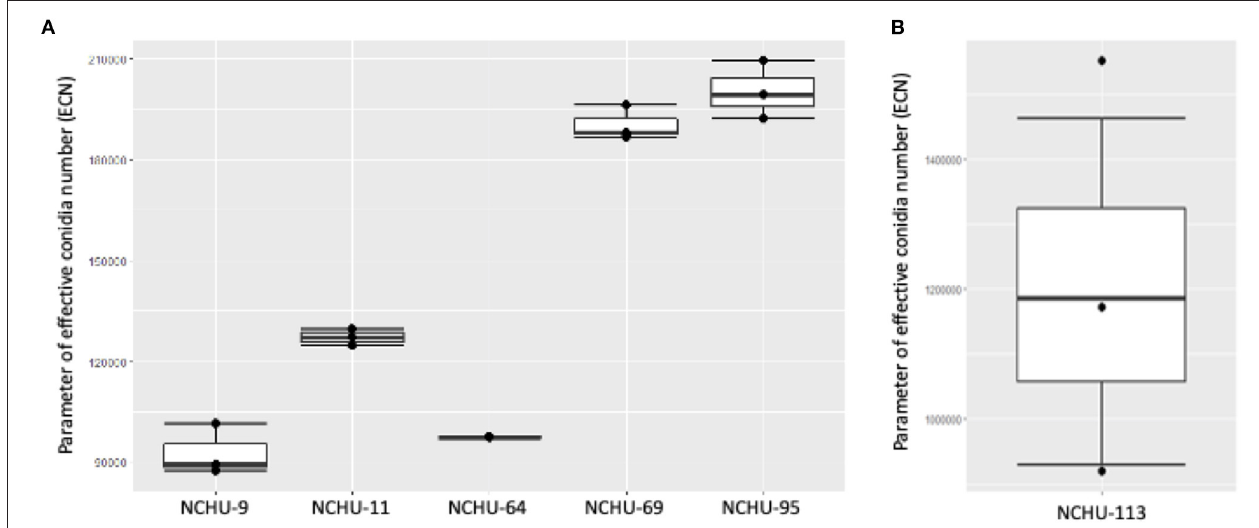
FIGURE 8 | The effective conidia numbers (ECNs) of (A) Metarhizium spp. and (B) Beauveria australis six fungal isolates showed variation in thermotolerance and conidial production among these